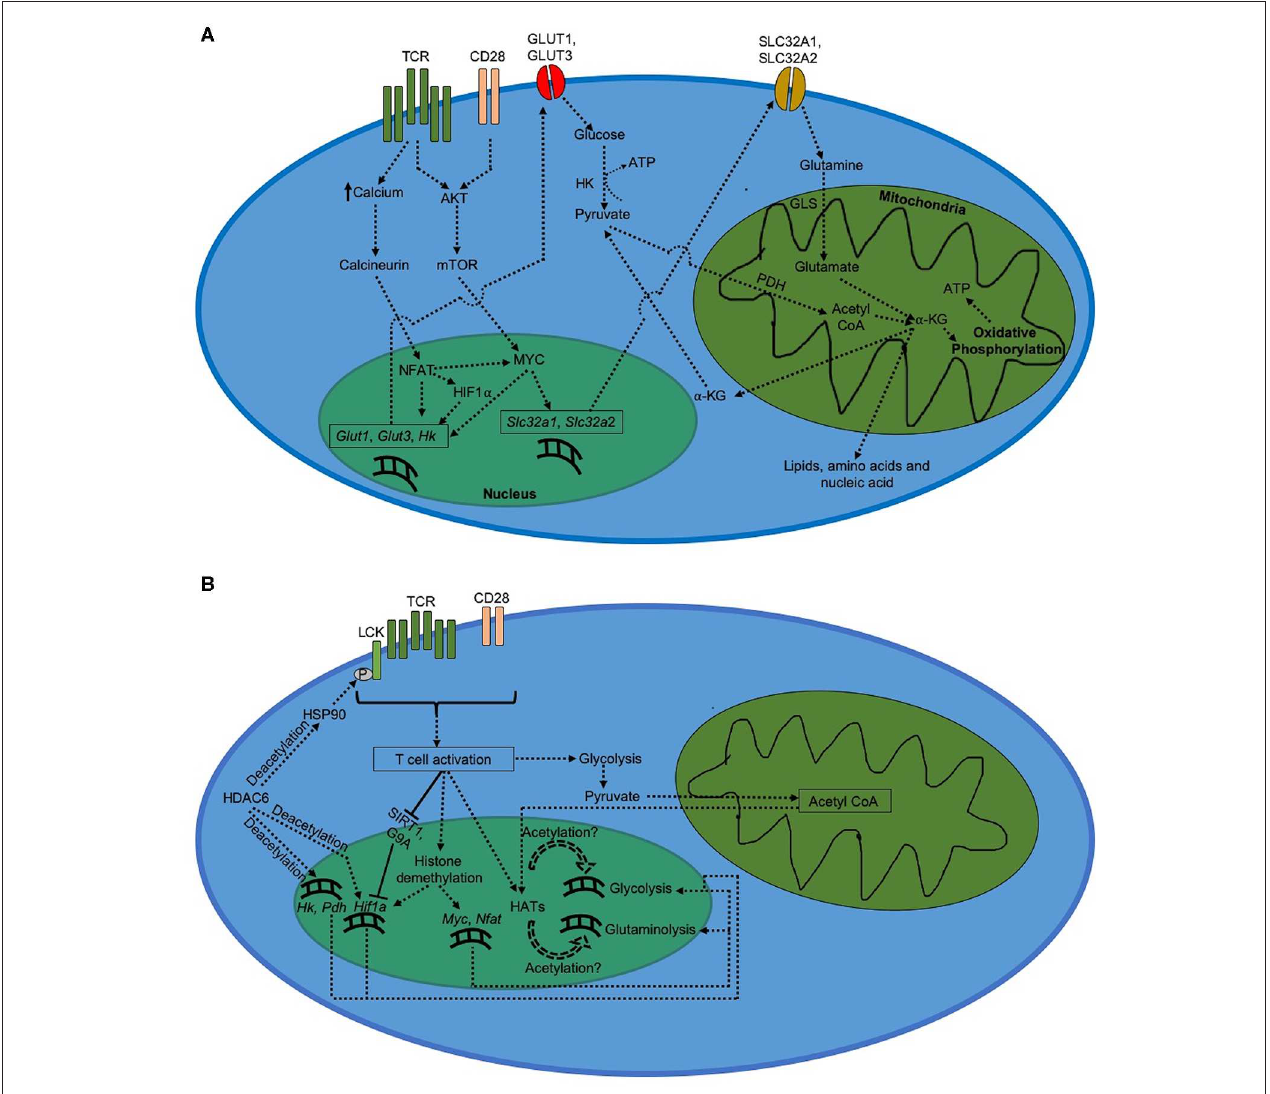
FIGURE 1 | Metabolism in CD8 + T cells after activation. (A) Regulation of metabolism during CD8 + T cell activation. Activated CD8 + T cells demonstrate a drastic increase in glycolysis and glutaminolysis, which serve to generate ATP as well as biogenic precursors for daughter cells. (B) Epigenetic regulation of metabolism during CD8 + T cell